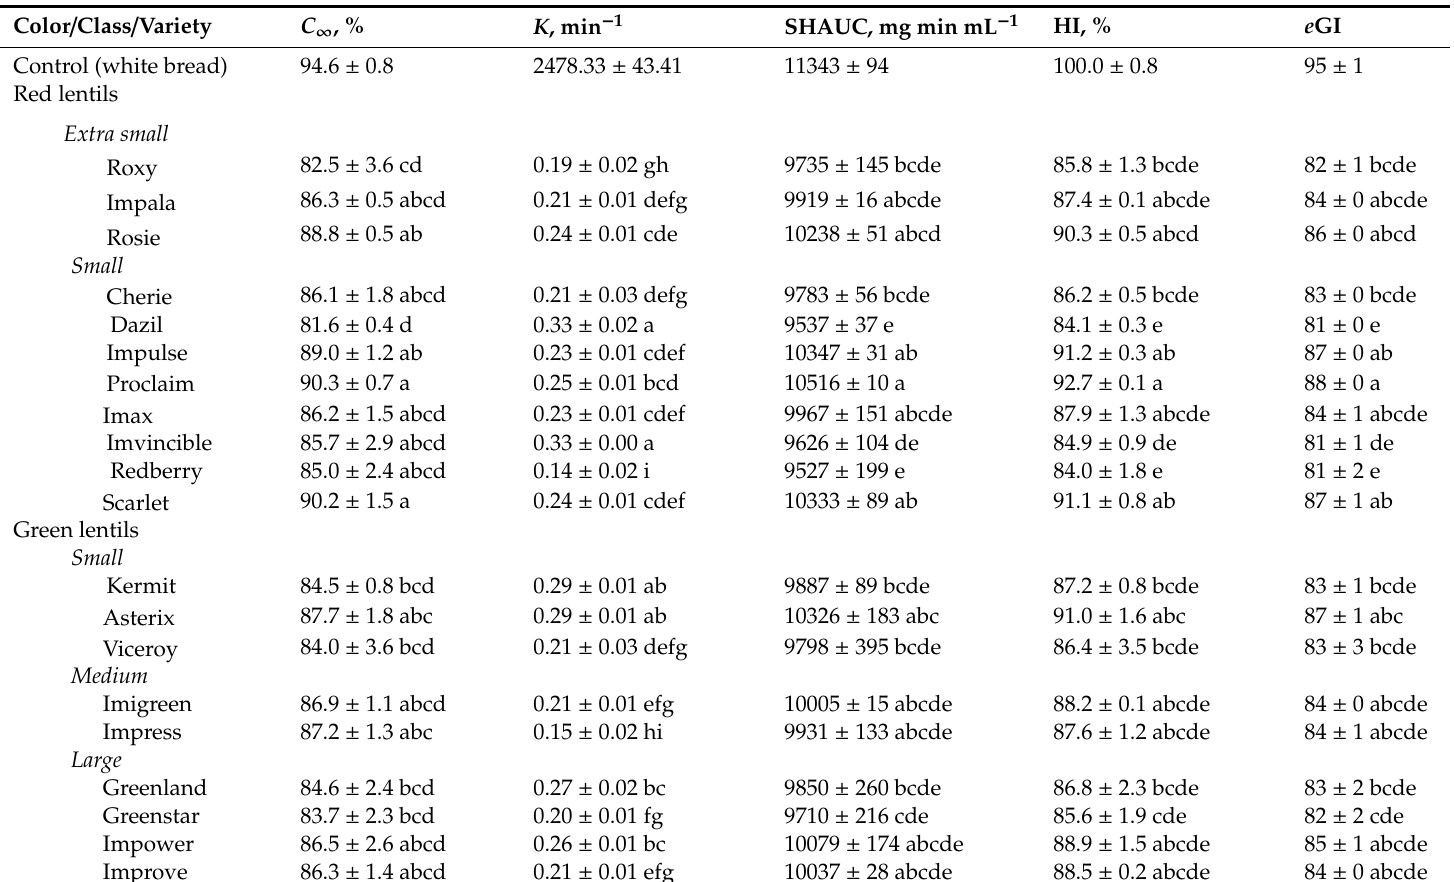
Table 4. Exponential model parameters ( C ∞ , k ), area under the curve (SHAUC), hydrolysis index (HI), and estimated glycemic index ( e GI) of Canadian lentil